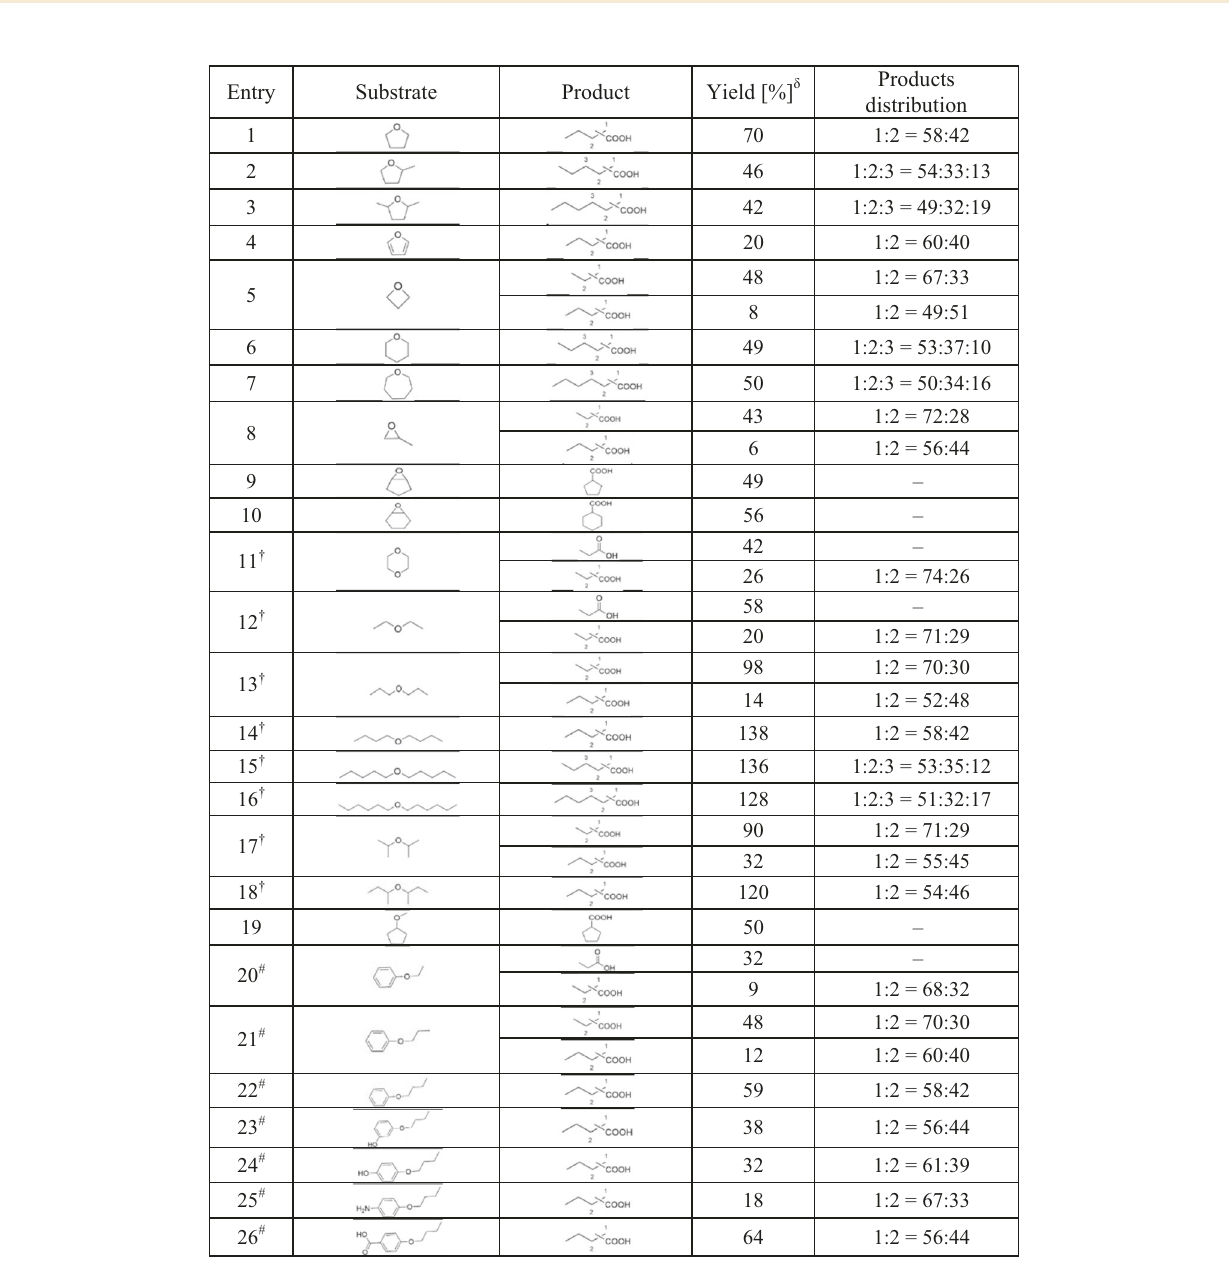
Table 2 Synthesis of higher carboxylic acids using various ether